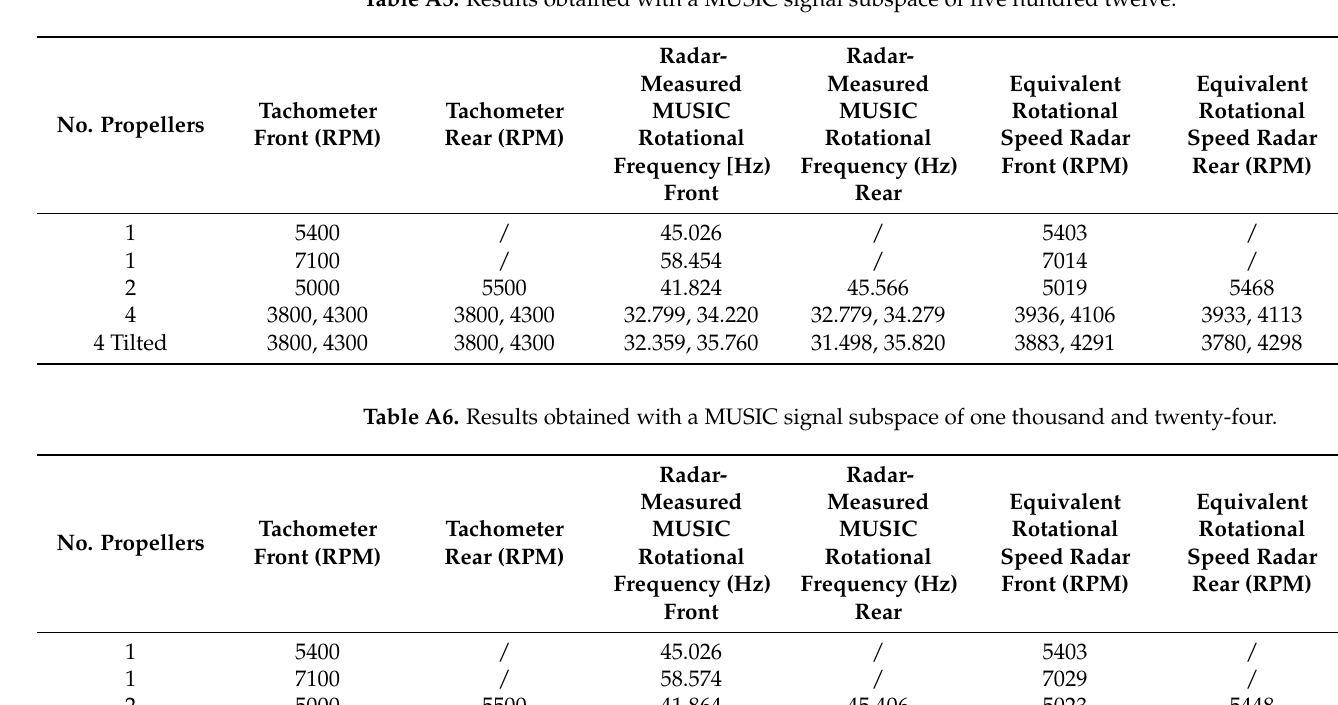
Table A5. Results obtained with a MUSIC signal subspace of five hundred twelve.